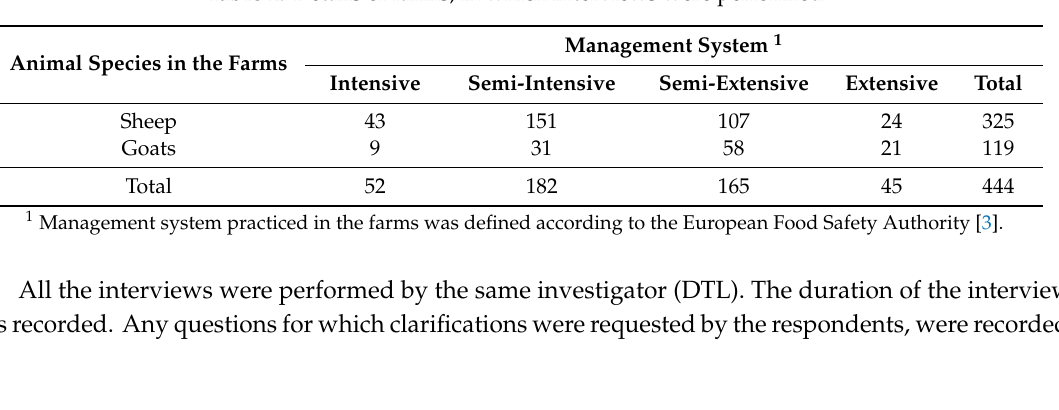
Table 2. Details of farms, in which interviews were